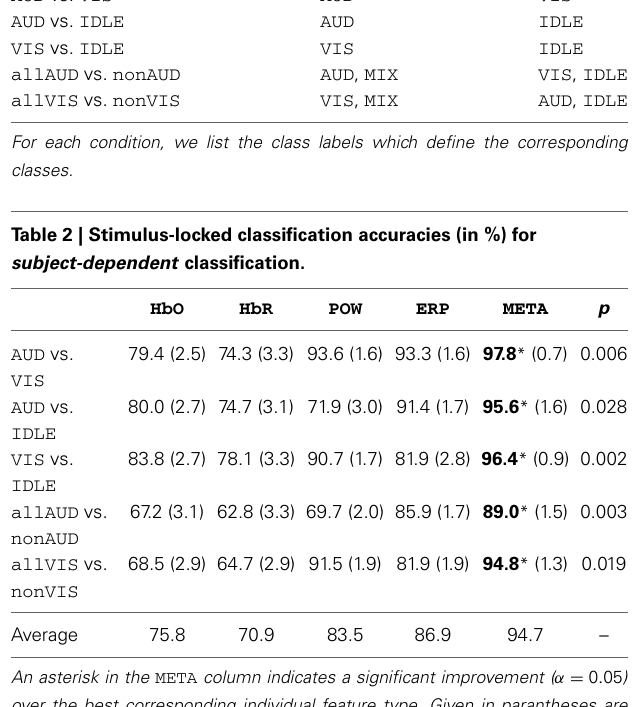
Table 4 . Both classifiers were very inconsistent in their results